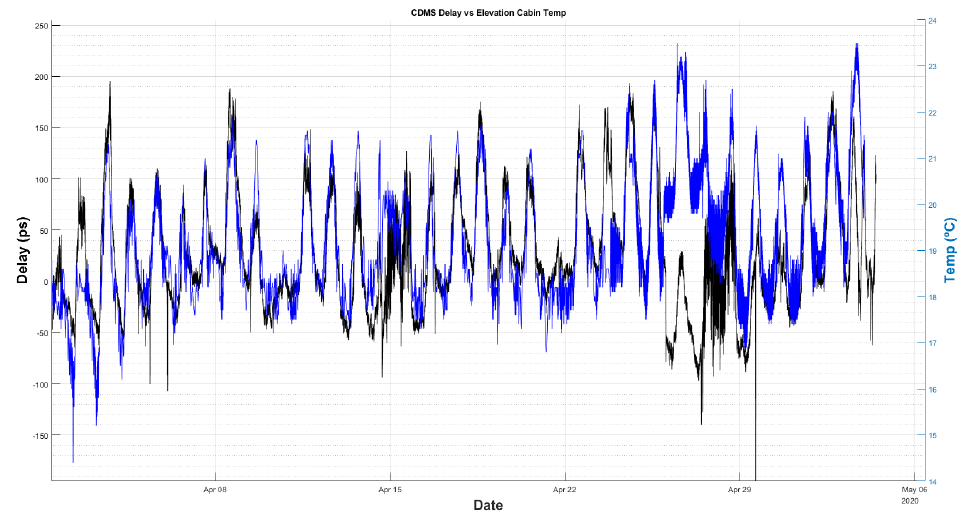
Figure 19. Comparison between delay (black) and receiver room temperature (blue).